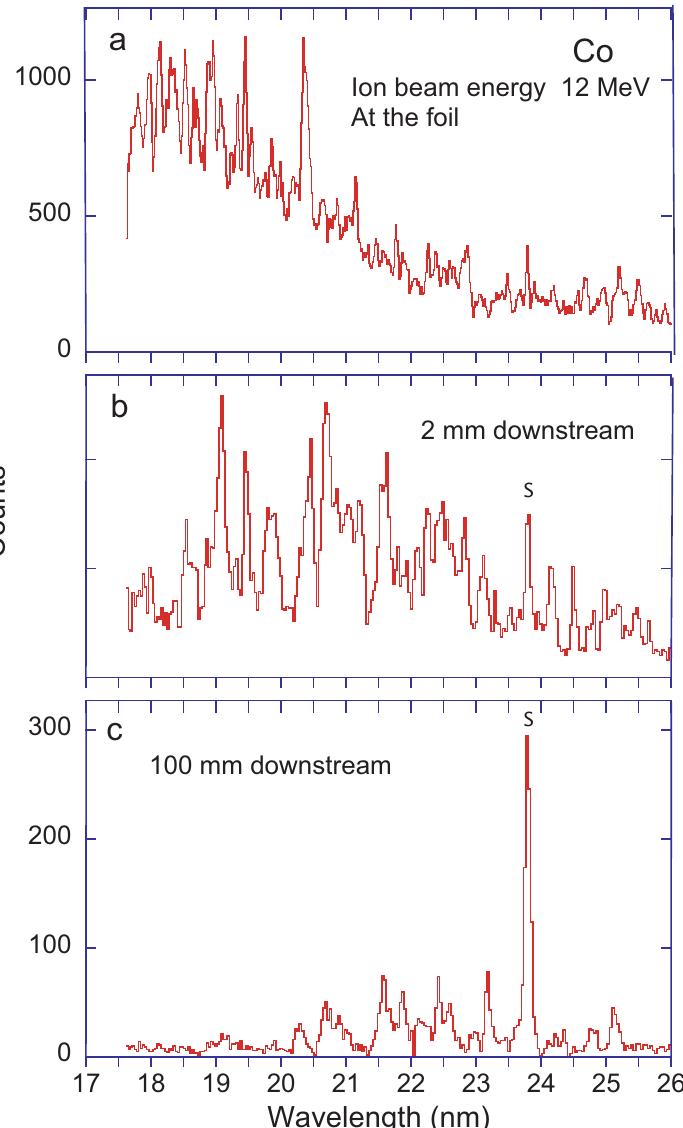
Figure 23. Beam-foil spectra of Co at an ion beam energy of 12MeV. Observation ( a ) at the foil, line width (FWHM) 0.06nm; ( b ) 2mm downstream (200ps delay), line width (FWHM) 0.09nm; ( c ) 100mm downstream of the foil (delay 16ns), line width (FWHM) 0.12nm. A cluster of CoXII (S-like) lines is